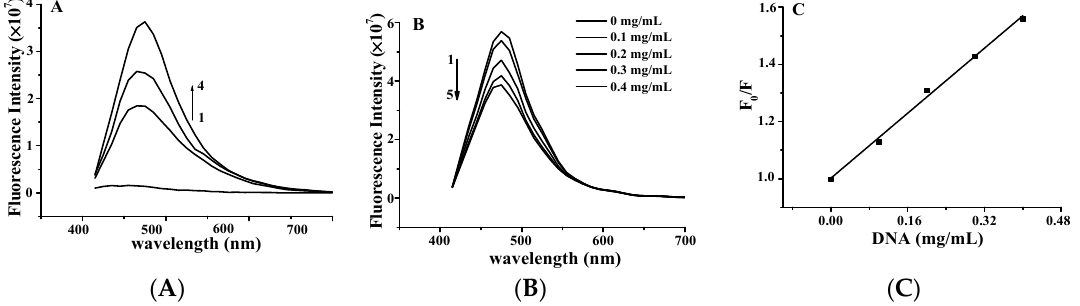
Figure 3. ( A ) Fluorescence quenching spectra of DNA–YP complexes ( C DNA = 0.9 mg/mL) upon addition of different YP concentrations: (1) 0 mg/mL, (2) 0.9 mg/mL, (3) 1.1 mg/mL, and (4) 1.3 mg/mL. ( B ) Effect of DNA on YP fluorescence spectrum. ( C ) Stern–Volmer plot for binding of YP by DNA at room temperature.